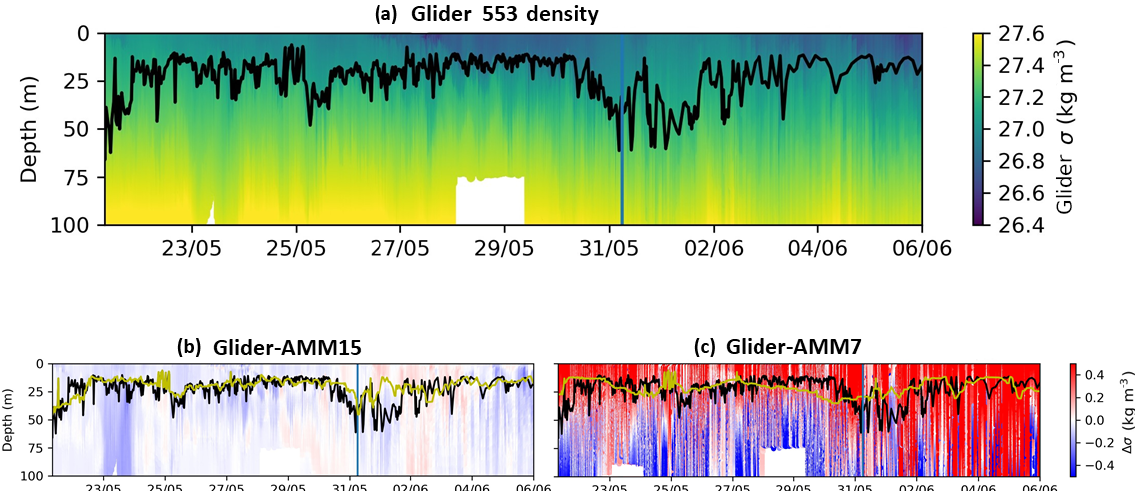
Figure 17. Top 100m density profile along glider 553-100 trajectory. (a) Salinity measured by the glider. (b) Difference between the glider and AMM15. (c) Difference between the glider and AMM7. The vertical blue line represents time when the glider goes over the shelf break, crossing the 200m isobath. Before that time, the glider is on the shelf. The black line is the MLD computed from the glider measurements; the yellow line is the model